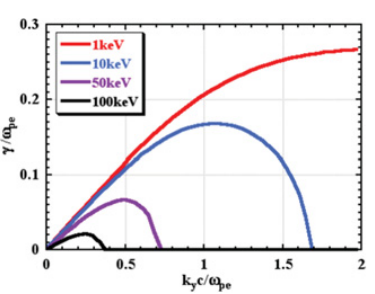
Figure 1. The linear growth rates of the Weibel